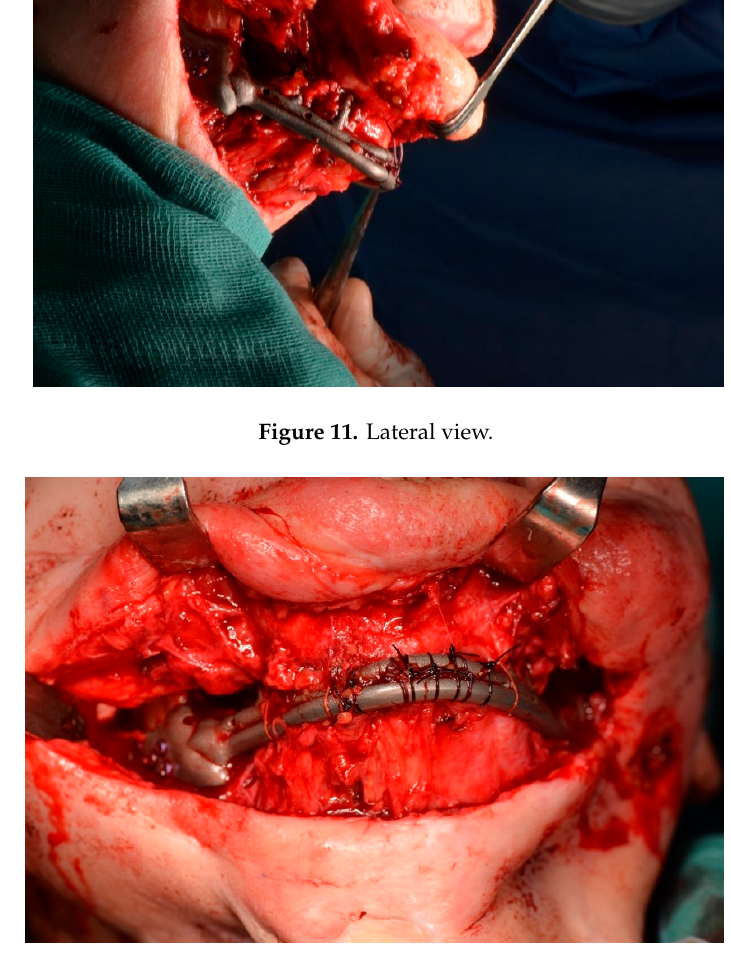
Figure 12. Suspension of soft tissue and overioid muscles to the anterior portion of the prosthesis.